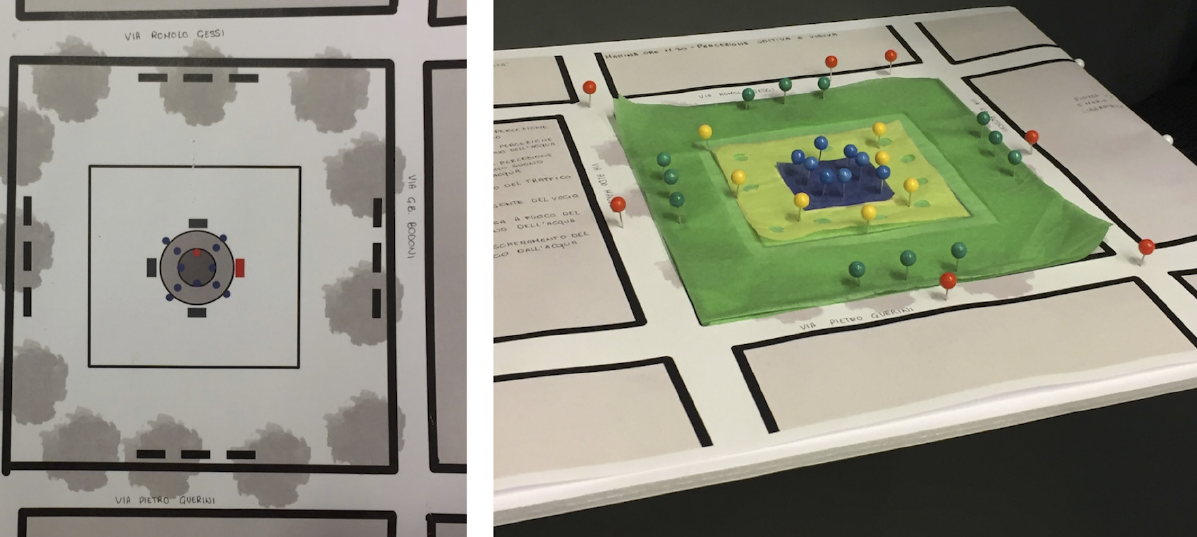
Figure 1: Piazza Testaccio, (A) top view of the area: the map takes reference points in the pavement of the square: the trees, the road, a step limiting the central pedestrian area, and a different tile line forming a square around the fountain. The red dot shows the closed tap, the red rectangle shows the closed manhole. (B) Sonic perceptual survey in tissue paper layers and pins. Pins describe individual percep- tions, tissues regard a looser qualitative assessment of the collective survey. Tissue Paper legend green: chattering; yellow: feeble water sound; blue: emergent water sound. Pins-head legend green: sources of chattering; yellow: exact spots where the sound of water becomes perceivable to the single surveyor; blue: places where the sound of water covered other sounds; red: